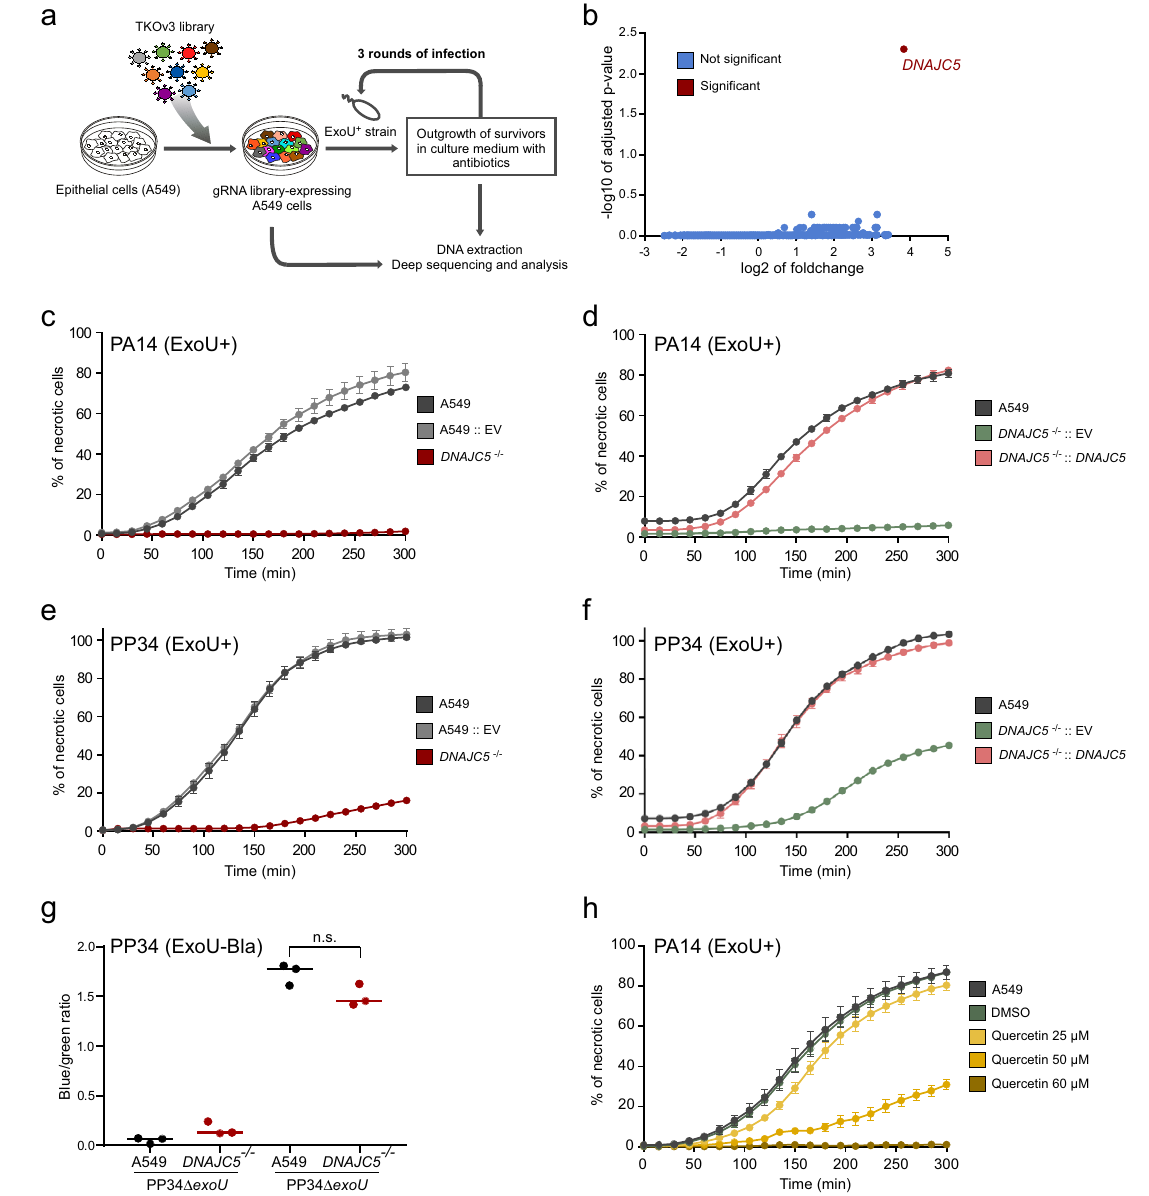
Fig. 1 DNAJC5 is required for ExoU cytotoxicity. a Screening process to identify host genes required for ExoU toxicity. A gRNA library (TKOv3, four gRNAs per gene) was constructed for A549 human epithelial cells. Cells were subjected to three 90-min rounds of infection with the ExoU + PA14 strain in triplicates. Infection was stopped by washing and adding antibiotics. DNA, corresponding to gRNAs from resistant cells and from the uninfected library, were then ampli fi ed by PCR and submitted to deep sequencing. b Analysis of sequencing data. Statistical analysis of gRNA abundance in infected vs uninfected conditions. gRNAs targeting the DNAJC5 gene were the only ones signi fi cantly enriched in the screen. c Cytotoxicity assay. A clonal population of DNAJC5 − / − A549 cells, native A549 cells or cells transfected with an empty vector (EV) were infected in triplicates with PA14 and necrosis was monitored by propidium iodide incorporation, recorded by time-lapse microscopy. Results are represented as the mean percentage (±SD) of necrotic cells. d Cytotoxicity assay with A549 native cells. DNAJC5 − / − cells complemented with DNAJC5 (DNAJC5 − / − ::DNAJC5), or the mock-complemented control, were infected with PA14. Results ( n = 4 replicates) are represented as the mean percentage (±SD) of necrotic cells. e , f Cytotoxicity assays and representation are similar to ( c , d ), but cells were infected with the ExoU + PP34 strain ( n = 3 and 4 for ( e ) and ( f ), respectively). g T3SS-dependent injection of ExoU in A549 epithelial cells. A549 or DNAJC5 − / − cells were infected with PP34 Δ exoU expressing ExoU S142A fused to the β - lactamase (Bla) or infected with uncomplemented PP34 Δ exoU . Cells were loaded with CCF2, a fl uorescent substrate for Bla, which shifts from green to blue fl uorescence upon processing by the enzyme. Fluorescence was measured at 4 hpi on both channels and results are expressed as a blue/green ratio ( n = 3; bar: median). Statistical differences between data in A549 and DNAJC5 − / − cells infected with the exoU-bla strain were calculated with a two-sided Student ’ s test, and were not signi fi cant (n.s.). h Cytotoxicity assay. Increasing concentrations of quercetin were added to A549 cells in the presence of PA14 (ExoU + ) at an MOI of 10. Necrosis was monitored by PI incorporation and recorded by time-lapse microscopy. Results ( n = 8 replicates) are represented as the mean percentage (±SD) of necrotic cells. Source data are provided as a Source Data fi